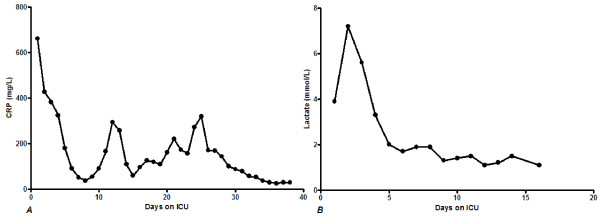
C-reactive protein and lactate concentrations over time of the first case. A C-reactive protein concentrations and B Lactate concentrations. C-reactive protein levels and lactate concentrations decreased to near normal values during the ICU stay.